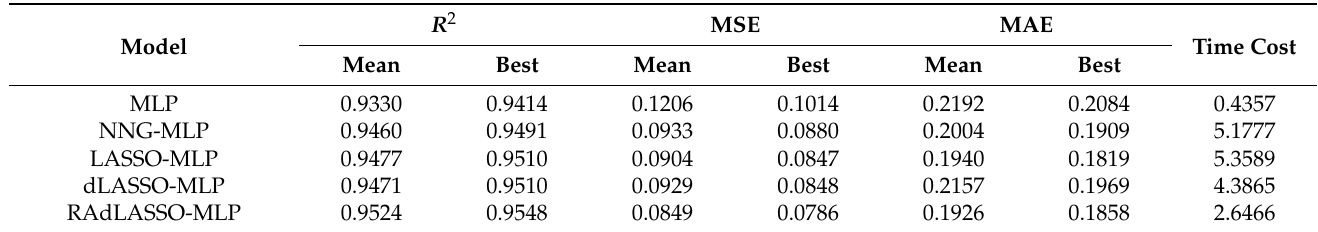
Table 2. Comparison results of different algorithms for normal data ( X 2 ∈ R n × 10 ).